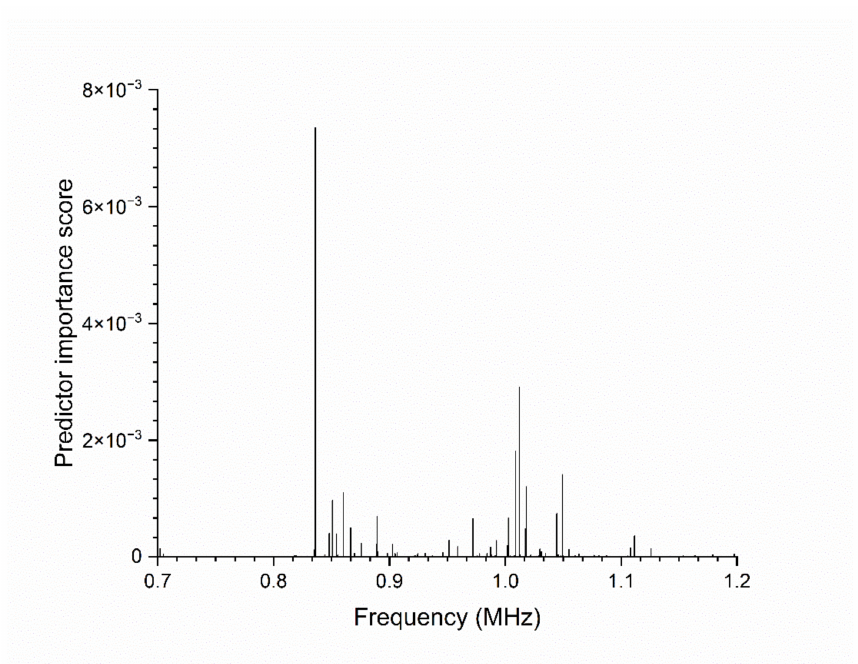
Figure 4. Predictor importance score of the frequencies for feature selection around the main fre- quency of the ultrasound sensor (1